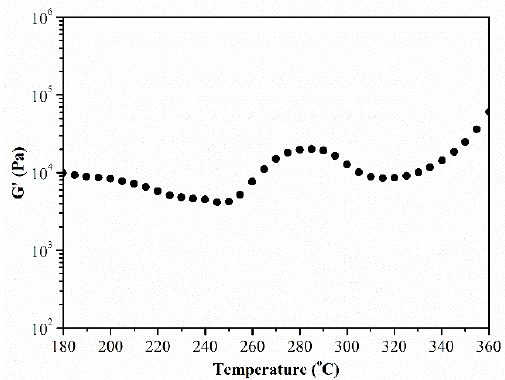
Figure 2. Rheological properties as a function of temperature.